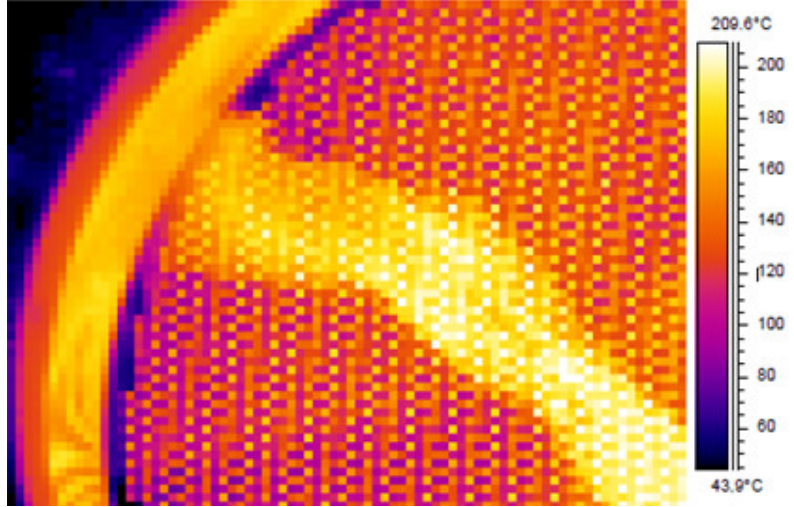
Figure 7. IS acceleration electrode